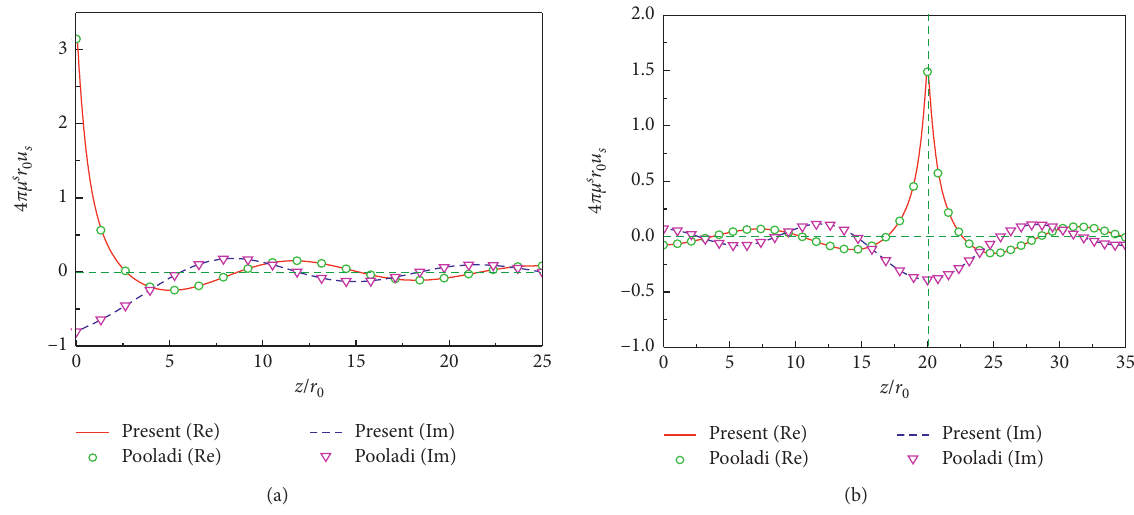
􏽰 ���� � 0 . 5): (a) s � 0; (b) s � 20 r � ω r / μ s / ρ s 0